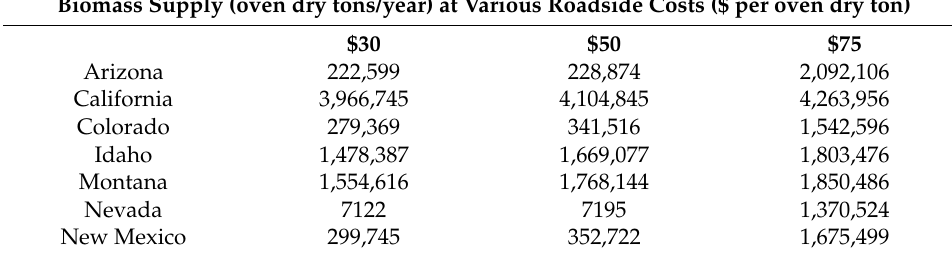
Table 4. Base case cumulative forest biomass supply by state and roadside